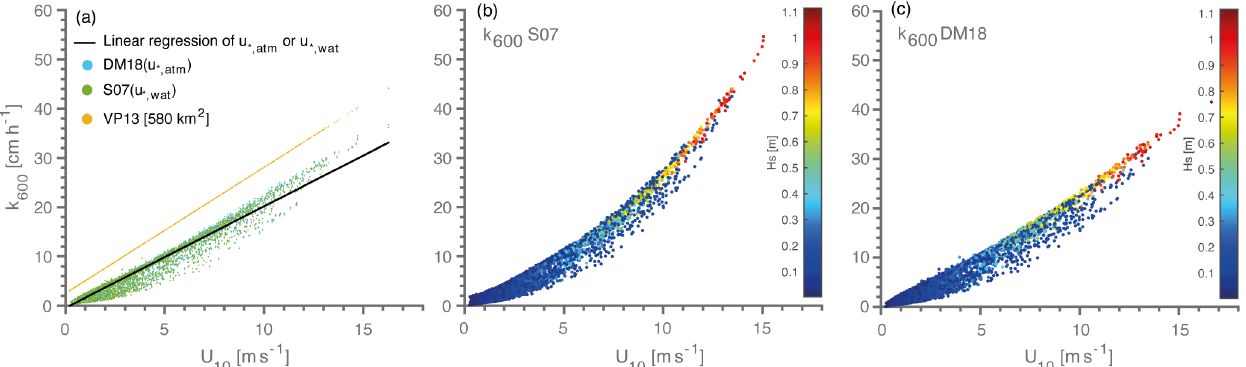
Figure B1. Panel (a) shows the comparison of Soloviev et al. (2007) and Deike and Melville (2018) for the first-order function of friction velocity at the water side ( u ∗ , wat ) (blue points) and at the atmosphere side ( u ∗ , atm ) (green points) with their linear regression (black line), the linear function of Vachon and Prairie (2013) for a lake size of 582km 2 (yellow points), and the linear regression from u ∗ , wat or u ∗ , atm . Panel (b) is a visualisation of S07 with empirical parameterisation of the bubble term (Woolf, 1997) regardless of wave height as a function of wind speed at 10m. Panel (c) is a visualisation of DM18 as a function of wind speed, only using the effect of the bubble term from 10ms − 1